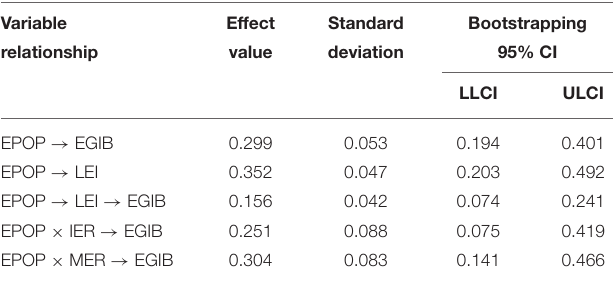
TABLE 5 | Bootstrapping tests of mediating effect and moderating